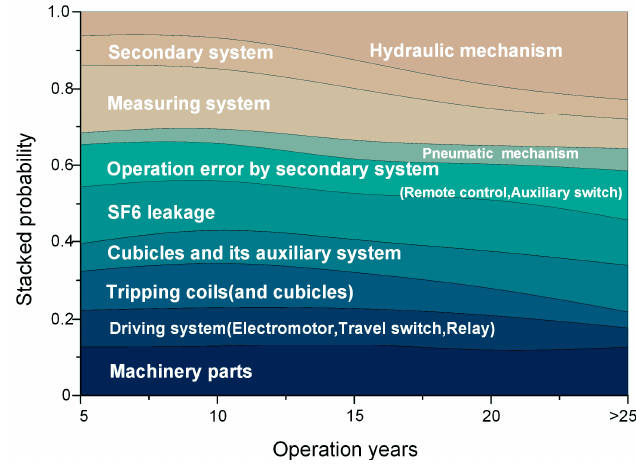
Figure 12. Average time-varying dynamics of the extracted 10 failure patterns.